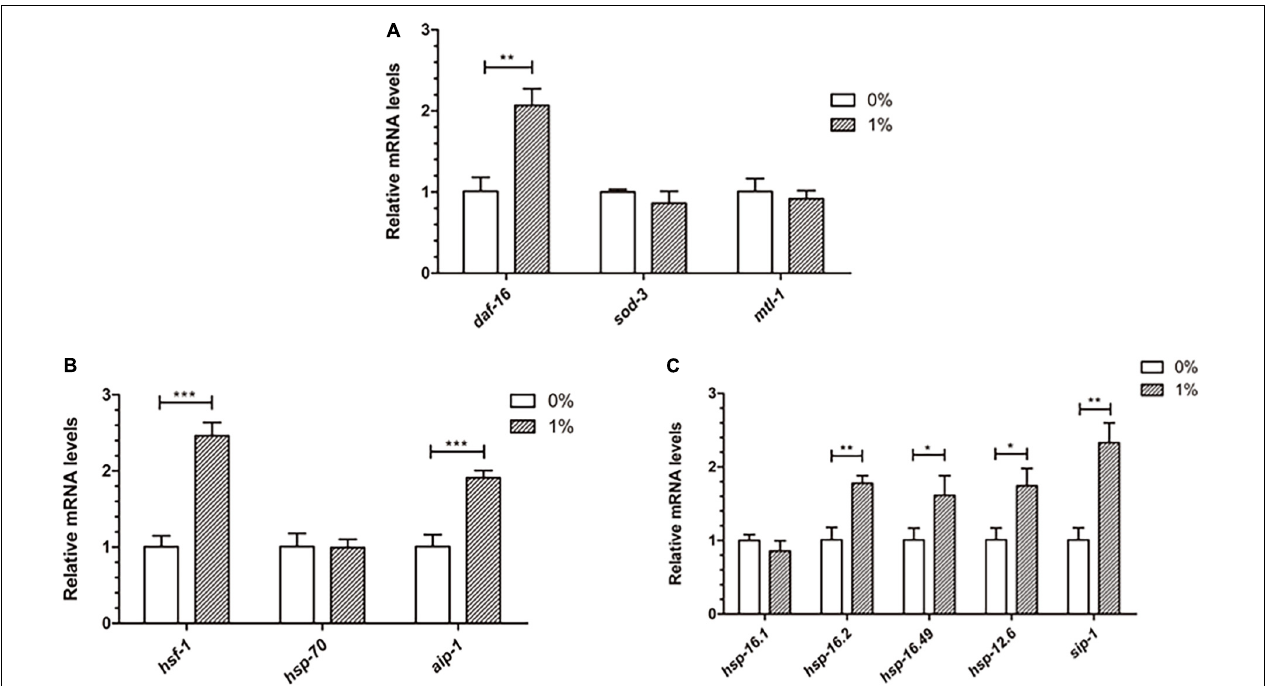
FIGURE 6 | Effect of ethanol on the expression of stress resistance genes in worms. (A) The expression of daf-16 and downstream target genes ( sod-3 , mtl-1 ) was performed by qPCR, n = 500. (B) The relative mRNA level of hsf-1 and downstream target genes ( hsp-70 , aip-1 ) was measured by qPCR. (C) The expression of small heat shock protein genes ( hsp-16.1 , hsp-16.2 , hsp-16.49 , hsp-12.6 , sip-1 ), common downstream target genes, was determined by using qPCR. Graphs represent mean ± SD. * p < 0.05, ** p < 0.01 and *** p <